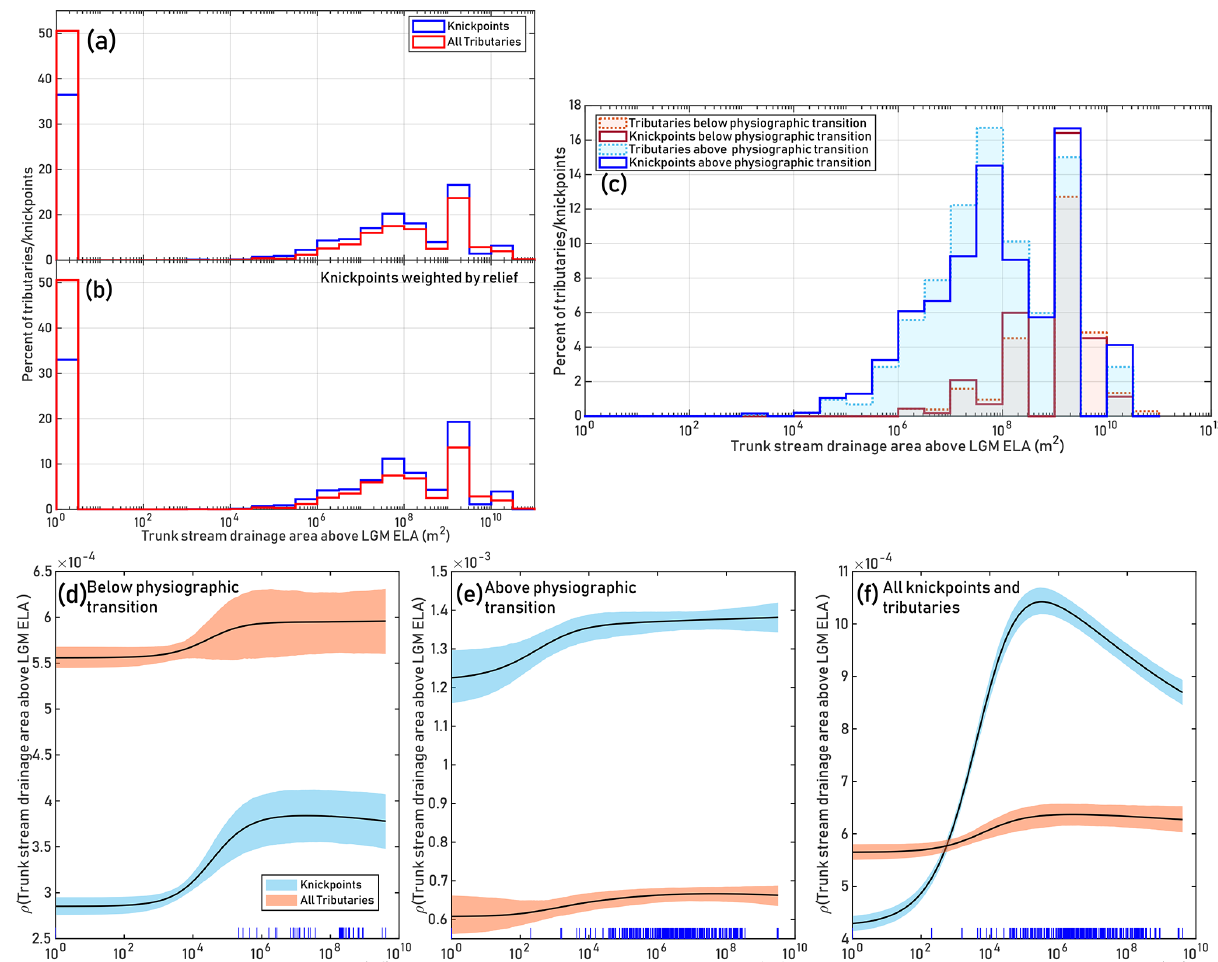
Figure 4. (a) Distribution of knickpoints ( n = 3707) and analyzed first- and second-order tributaries ( n = 3557) to third- or higher-order rivers with respect to the area of terrain above the ELA drained by the trunk stream. Knickpoints included in the analysis are located on a first- or second-order tributary within 2km of a confluence with a third- or higher-order trunk stream. Area is log-binned; the lowest area bin contains only knickpoints and confluences where the trunk stream does not drain any terrain above the ELA. See the “Methods” section for criteria for identifying knickpoints. (b) Same as (a) , but knickpoints are weighted by their relief. For both the relief-weighted and non-weighted knickpoint distributions, we conducted two-sample Kolmogorov–Smirnov tests for the distributions of knickpoints versus confluences with respect to above-ELA drainage areas and found that the empirical CDF for the confluences is larger with P < 0 . 0001. (c) Comparison of knickpoints and tributaries located above ( n = 1472 tributaries, n = 2549 knickpoints) and below ( n = 2085 tributaries, n = 1152 knickpoints) the physiographic transition (PT) (Fig. 1). Including only those knickpoints and tributaries that drained to trunk streams with drainage area above the LGM ELA, we conducted two-sample Kolmogorov–Smirnov tests for the distributions of knickpoints versus confluences with respect to above-ELA drainage area and found that the empirical CDF for the confluences is larger with P ≈ 0 . 01 above the PT, while for the knickpoints below the PT we could not reject the null hypothesis with 95% confidence that they belong to the same distribution. (d–f) Results from “rhohat” function in TopoToolbox (Schwanghart et al., 2021), which returns the nonparametric dependence of the distribution of point features along a river network on a covariate, which in our case is upstream drainage area above the ELA in the trunk stream. Colored regions represent the bootstrapped uncertainty intervals and ticks along the x axis represent individual data points.